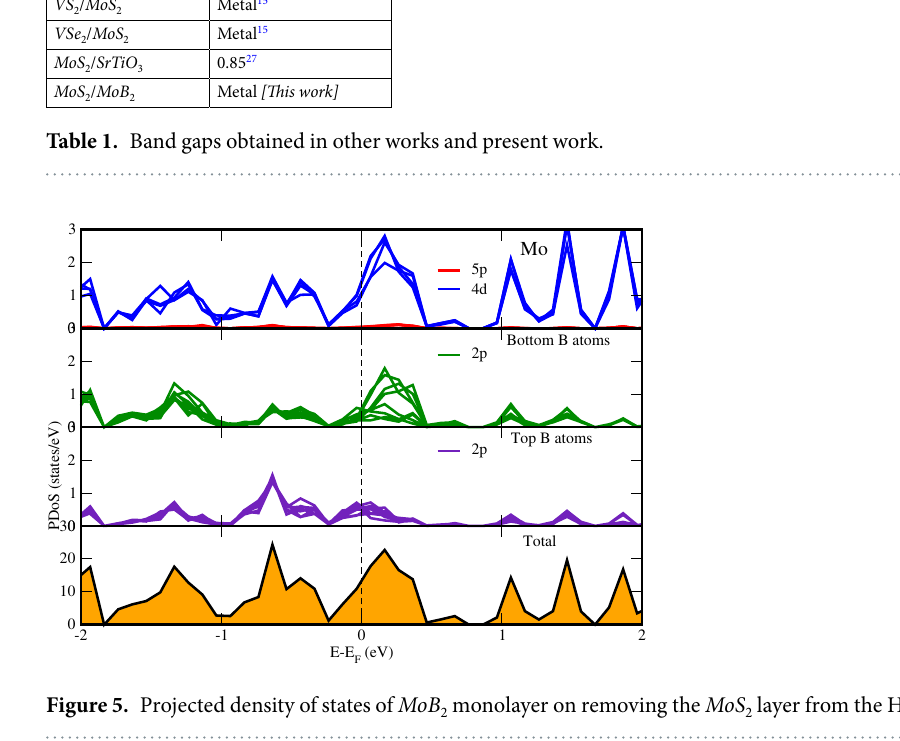
interfacial interactions may not be the Van der Waals interactions 27 . In order to analyze the nature of adsorp- tion at MoS 2 / MoB 2 interface with equilibrium interfacial distance ( d eq = 1.96 Å ), we have randomly shifted MoS 2 monolayer upward upto 4.76 Å and then downward upto 0.56 Å normal to the plane of MoS 2 / MoB 2 HS. The result obtained from adsorption curve in terms of change in potential energy with respect to interfacial distance is shown in Fig. 6(a), whereas the inset of Fig. 6(a) represents conventional potential energy versus interfacial dis- tance curve. The diagrammatic representation of shifting of MoS 2 monolayer over MoB 2 is provided in Fig. 6(b). With reference to Fig. 6(b) the distance d eq is set to 0 Å which indicates the minima of potential energy curve in Fig. 6(a). Again from Fig. 6(b) the maximum separation between MoS 2 and MoB 2 is ~4.76 Å which is then reduced to a minimum value ~0.56 Å . In Fig. 6(a) the two regions I and II can be allocated as chemisorption